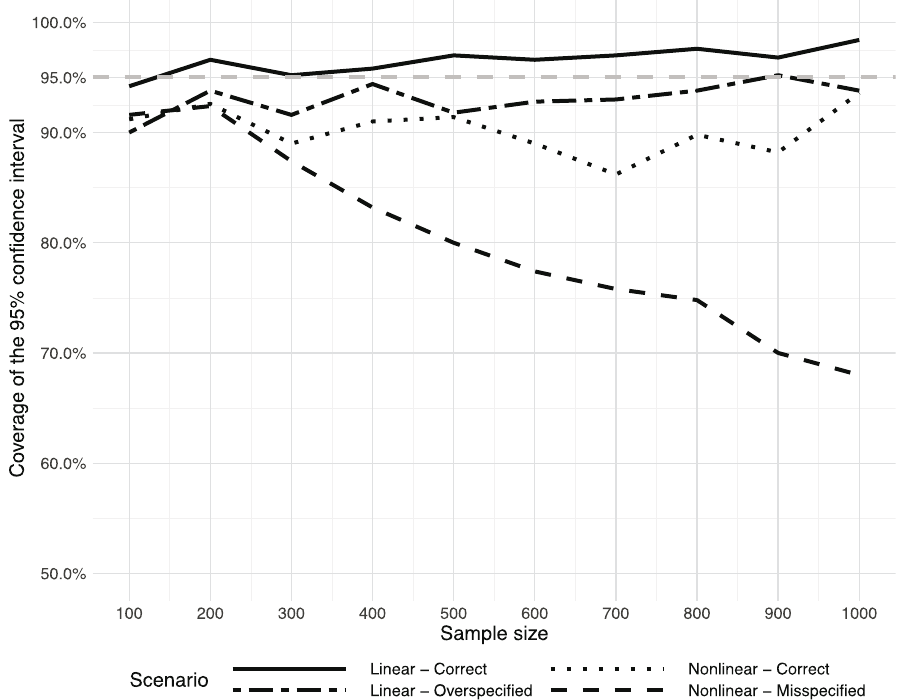
Figure 3: Coverage of the 95% Wald con fi dence interval using KOW across sample sizes and across simulation scenarios: linear - correct ( solid ) , linear - overspeci fi ed ( dot - dashed ) , nonlinear - correct ( dotted ) and nonlinear - misspeci fi ed ( dashed )